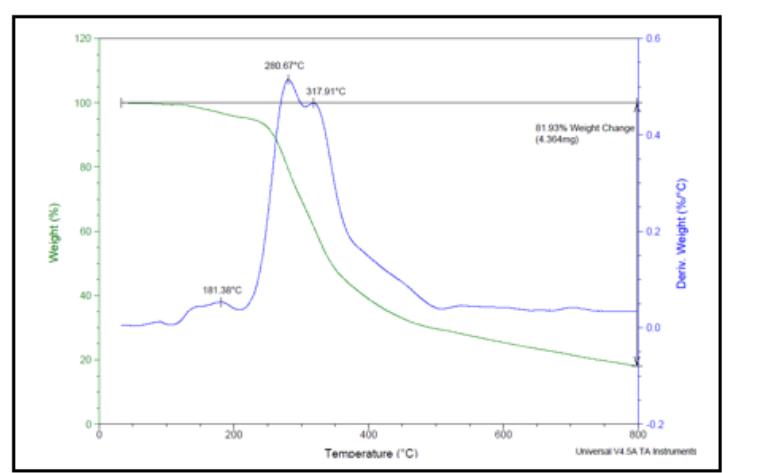
Fig. 12. TGA of PE polyester